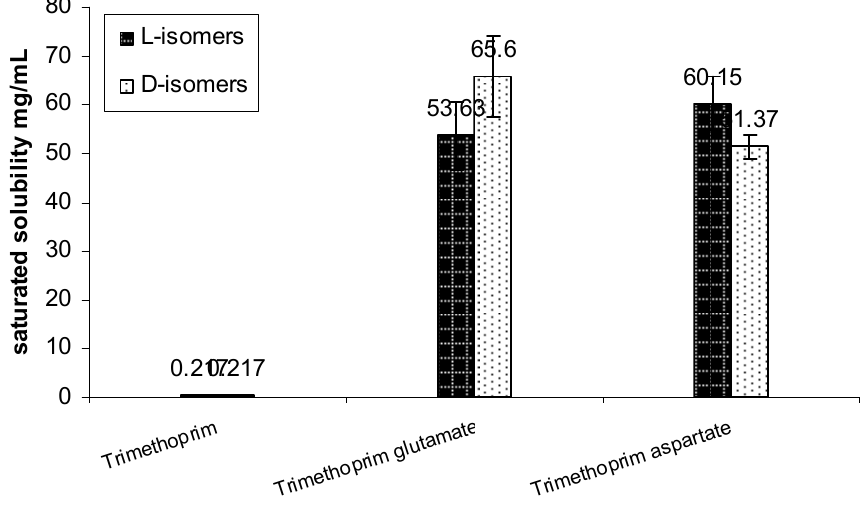
Figure 12. Dissolution profile for TMP free base and its salts in deionized water. Data are mean ± SD (n = 3).